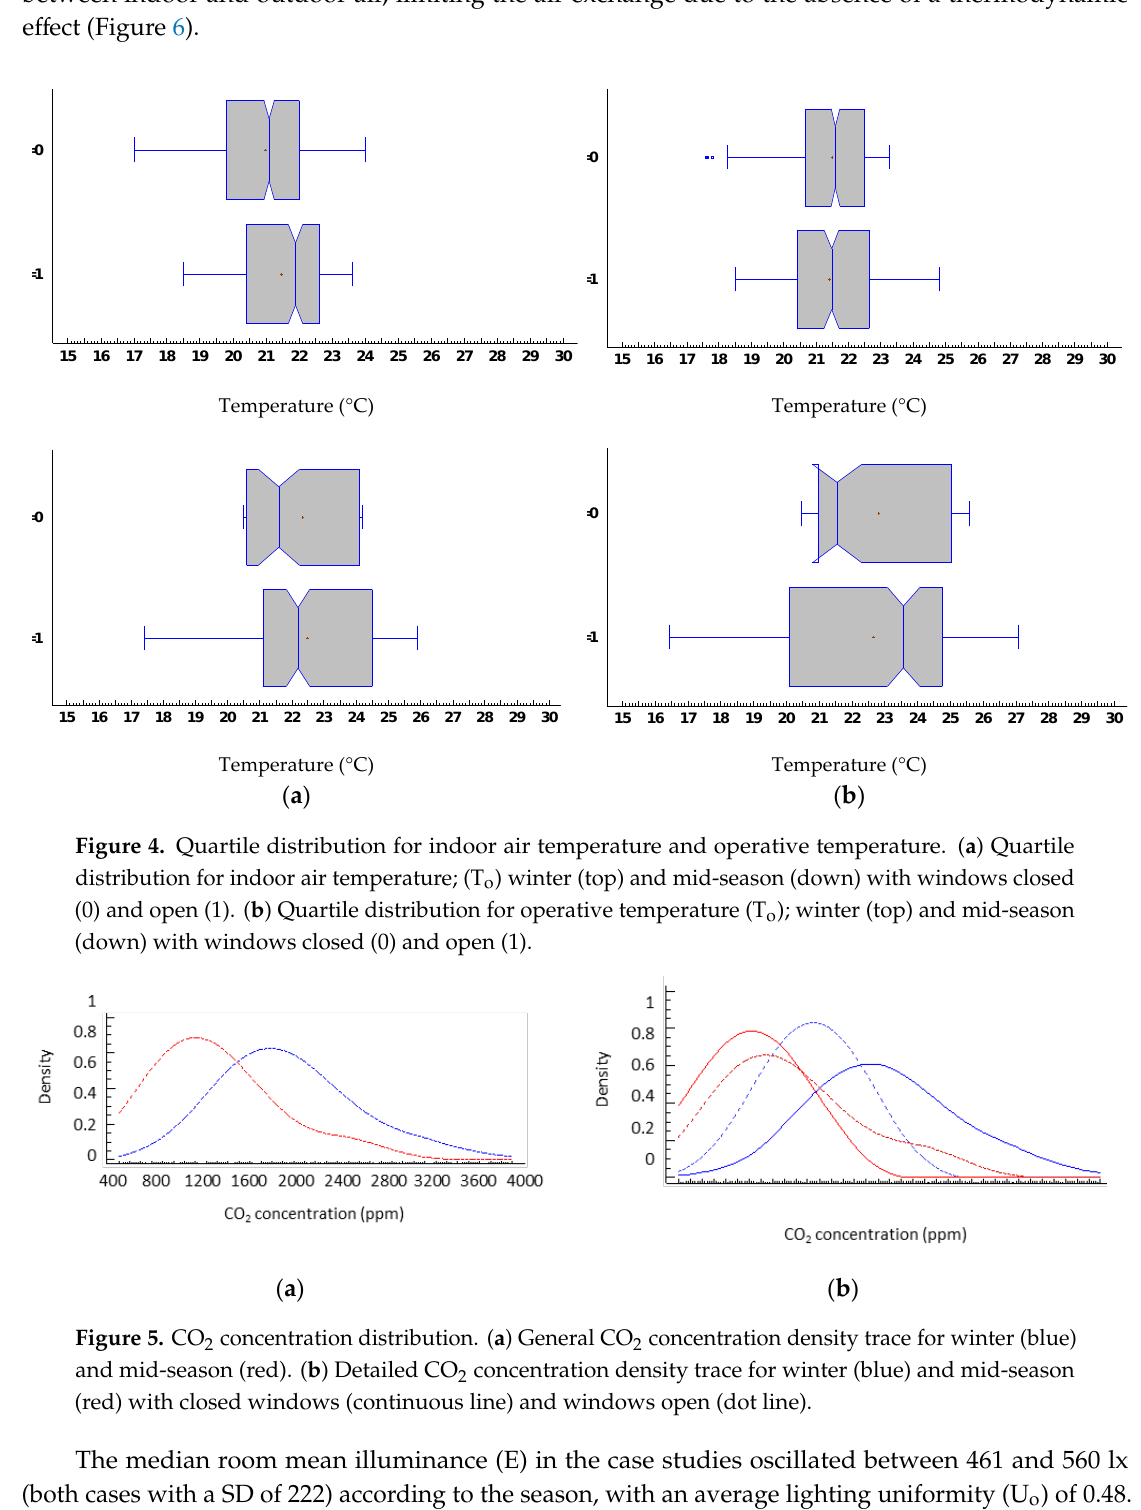
Figure 4. Quartile distribution for indoor air temperature and operative temperature. ( a ) Quartile distribution for indoor air temperature; (T o ) winter (top) and mid-season (down) with windows closed (0) and open (1). ( b ) Quartile distribution for operative temperature (T o ); winter (top) and mid- season (down) with windows closed (0) and open (1).